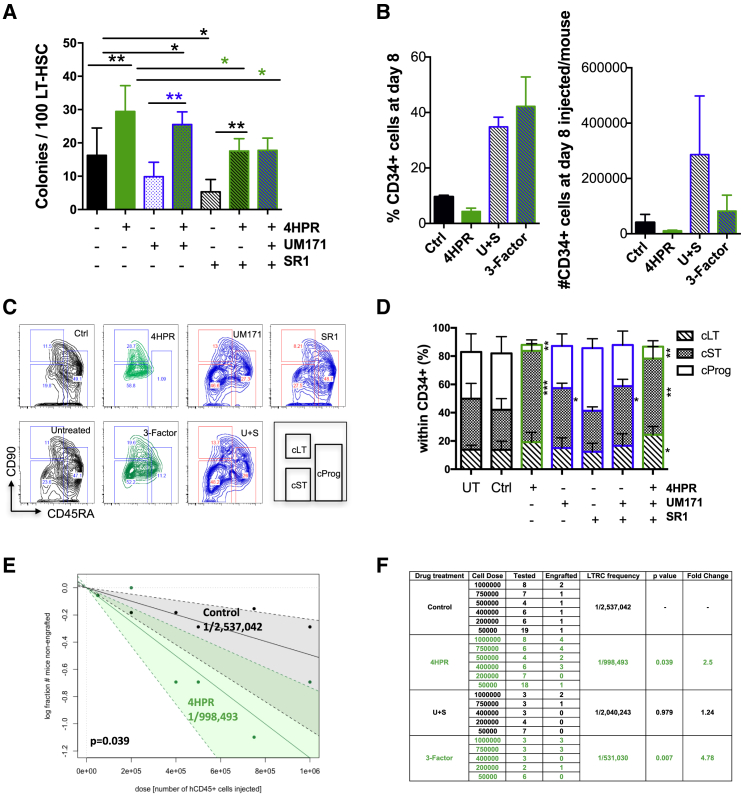
Sphingolipid Modulation Restricts Expansion of Committed Progenitors during Ex Vivo Culture to Enhance HSC Self-Renewal(A) Number of colonies for LT-HSC CFC assays with control (−) or the indicated combination of 4HPR, UM171, or SR1 at 10 days, unpaired t test relative to control (Ctrl, black) or to the presence or absence of 4HPR treatment.(B) Flow cytometry for the % and count (no.) of CD34+ cells subsequently transplanted per mouse following 8 days culture.(C) Representative flow cytometry plots for CD90 and CD45RA within the CD34+ fraction of lin− CB progeny at day 8 with the indicated treatments.(D) Distribution of cultured CD34+CD90+CD45RA− (cLT), CD34+CD90−CD45RA− (cST), and CD34+CD90−CD45RA− (cProg) for the treatments at day 8 following CD34 enrichment (n = 4); unpaired t test relative to control.(E and F) Graph of LTRC frequencies for control and 4HPR (E) and table summarizing results of secondary assays (F) with CD45+ cells isolated from 16-LTRC dose mice and transplanted at limiting doses for 16 weeks to calculate LTRC frequencies (5 biological experiments for control and 4HPR; 2 biological experiments for U+S and 3-Factor). Human CD45+ marking of >0.1% was considered positive for secondary engraftment. p value was by extreme limiting dilution analysis (ELDA).∗p < 0.05; ∗∗p < 0.01; ∗∗∗p < 0.001.